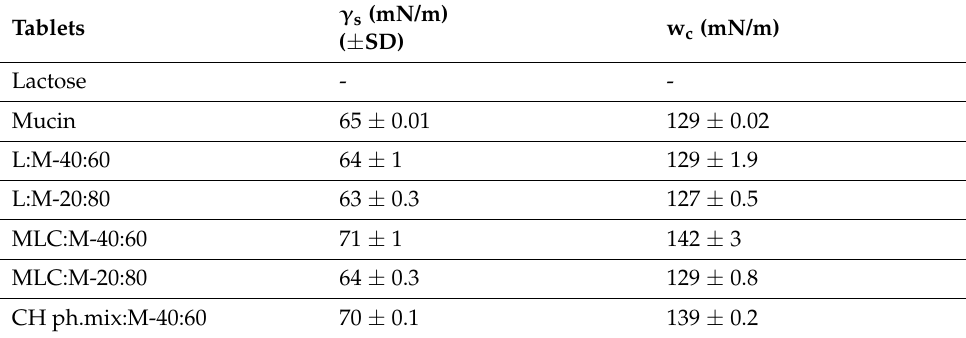
Table 7. Surface energy ( γ s ) and cohesion work (w c ) of tablets composed of lactose mucin,